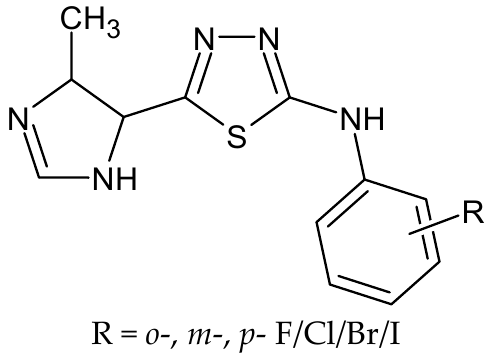
Figure 15. The structure of 1,3,4-thiadiazole derivatives.